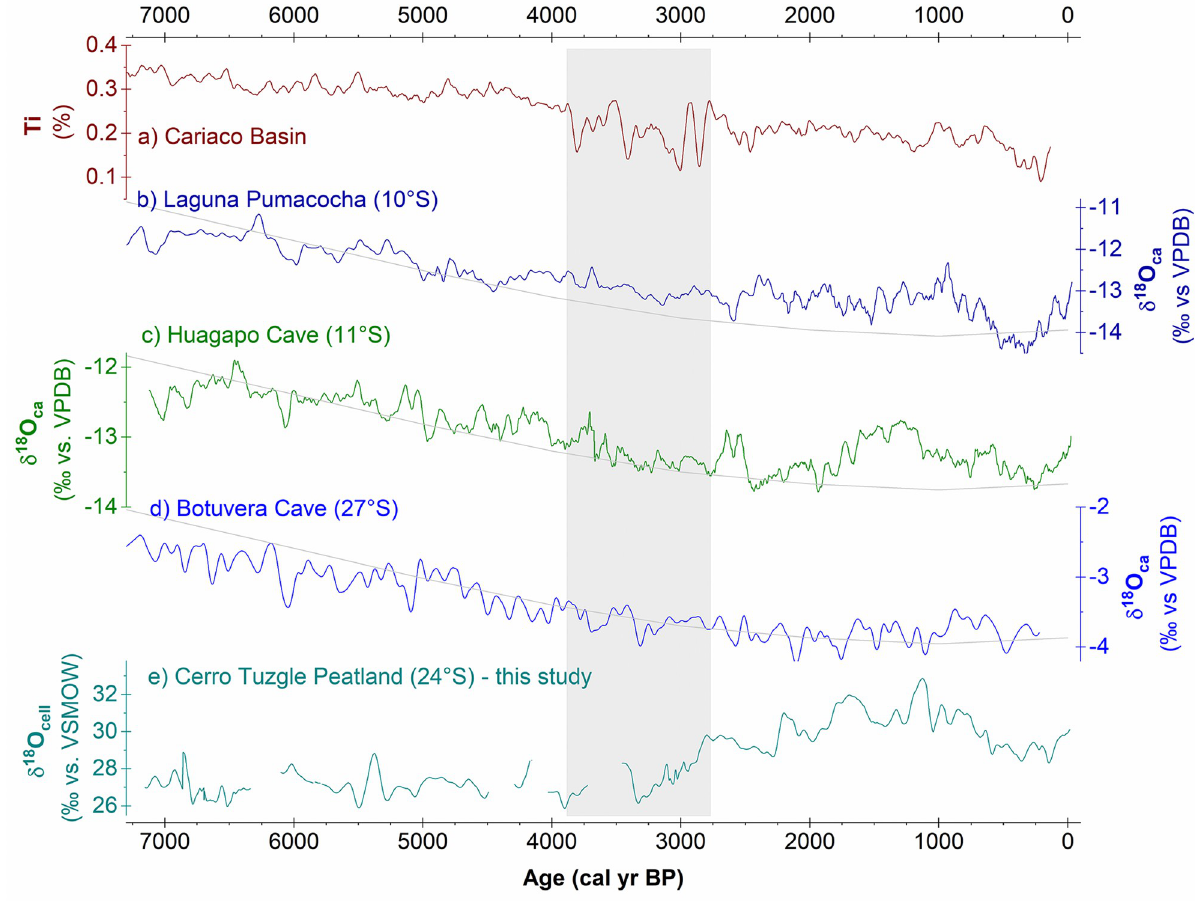
Fig 6. CTP record compared to proxy records for the ITCZ position and the SASM. (a) Cariaco Basin Ti content as proxy for the ITCZ position [71]. (b) Lacustrine carbonate δ 18 O of Laguna Pumacocha, Peru [67, 68], (c) stalagmite δ 18 O from Huagapo cave, Peru [69], and (d) stalagmite δ 18 O from Botuvera cave, SE Brazil [66] as proxies for SASM strength (lower values indicate intensified SASM). December insolation at 30˚S [72] indicated on reversed scale as grey line (scaling from 465 to 490 W/m 2 ). (e) Cellulose δ 18 O from CTP, Argentina, as hydroclimatic proxy. The grey bar indicates the window of transition mentioned in the text. All records are annualized and averaged with a 51-year moving average window.